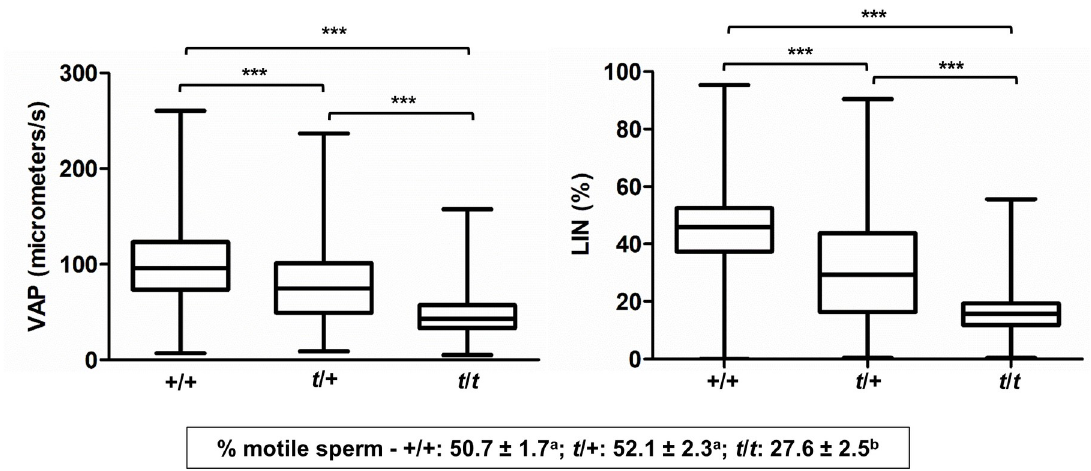
Fig 2. The t- haplotype impairs sperm progressive movement. Box plots (showing the median and first and third quartiles) with whiskers (from minimum to maximum) of average path velocity (VAP) and linearity (LIN) of sperm from wild type (+/+; n = 7151 sperm), heterozygous t ( t /+; n = 8335 sperm) or homozygous t ( t / t ; n = 813 sperm) mice, immediately after sperm isolation. Asterisks indicate statistically significant differences between genotypes ( ��� Ps < 0.001). The percentages of motile sperm (mean ± standard error; n = 15 +/+ samples, 15 t /+ samples and 15 t / t samples) are displayed in the bottom box (statistically significant differences between genotypes are indicated by distinct letters; Ps <